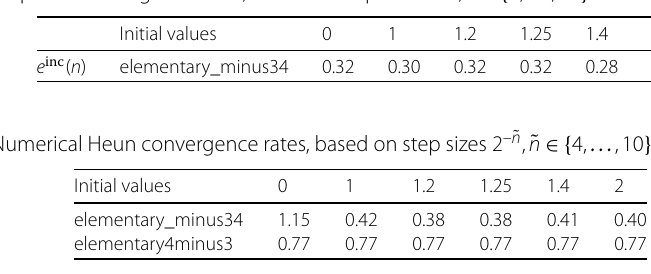
Table 3 Empirical convergence rates, based on step sizes 2 – ˜ n , ˜ n ∈ { 4, ... ,10 }